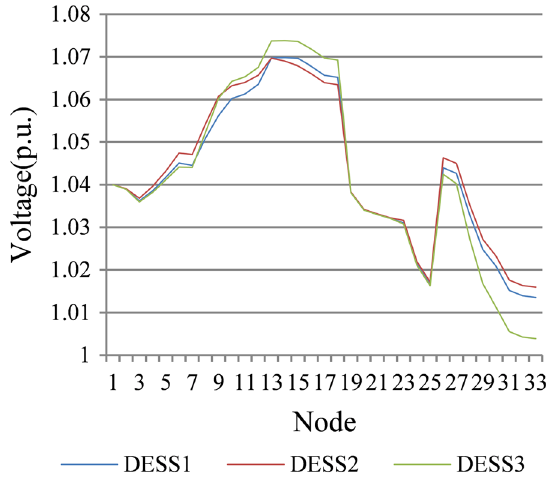
Fig. 9 Voltage profile of different DESS with different output power at